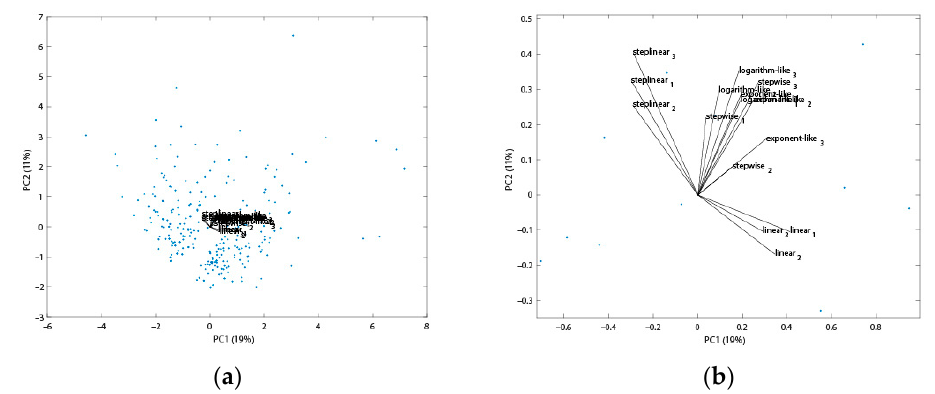
Figure 4. PCA biplot of the five different gradient types based on 274 proteins which were only either identified by the linear or step-linear gradient. ( a ) Zoom-out view, in which blue dots represent 274 proteins, the central part is the load plot; ( b ) zoom-in view of loading plot. The PCA was blinded to the 274 proteins which were either identified by the linear or step-linear gradient using MSFragger (Table S3).